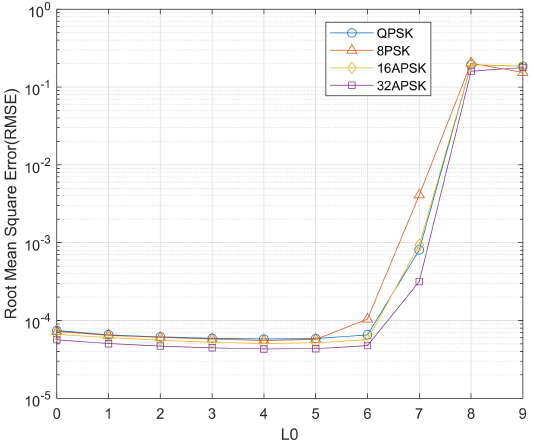
Figure 9. Effect of the number of superimposed pilot blocks on the performance of the RLR algorithm.